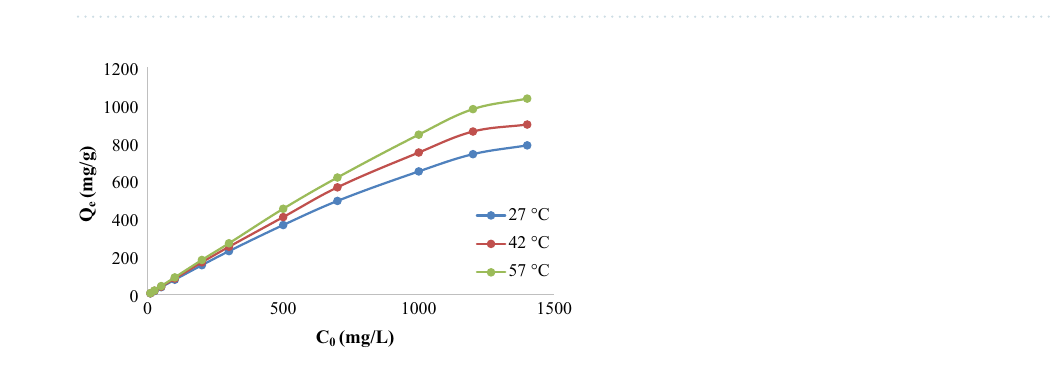
Figure 7. Impacts of initial concentration and temperature on the KMnO 4 adsorption by